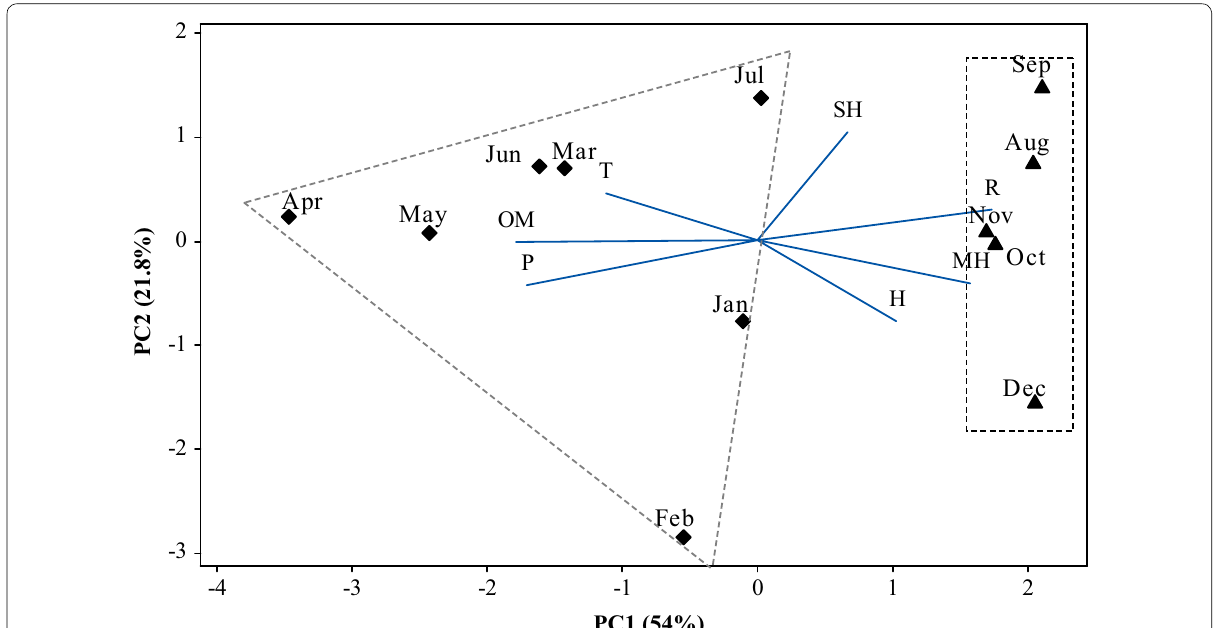
Fig. 2 Biplot (PCA) resulting from the analysis of the classes of compounds identified in the oils of L. thymoides of the seasonal study, in association with temperature, solar radiation, relative humidity, and